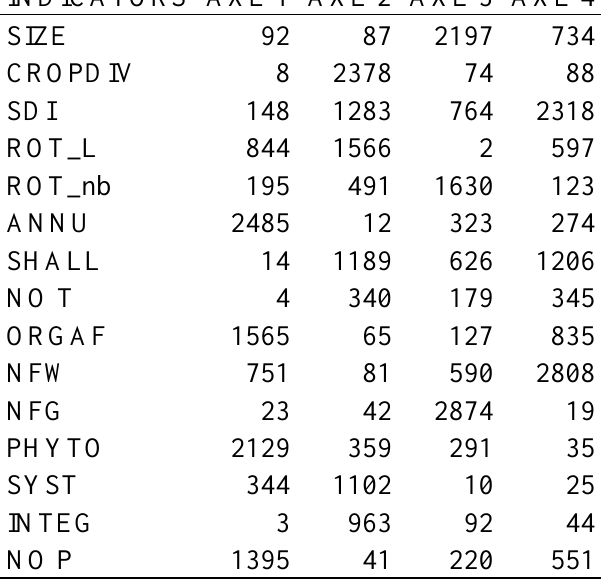
Table A1.1 Contribution of the indicators used for Typology 1 on the 4 axes (see Table 1 in the main text for the meaning of indicators’